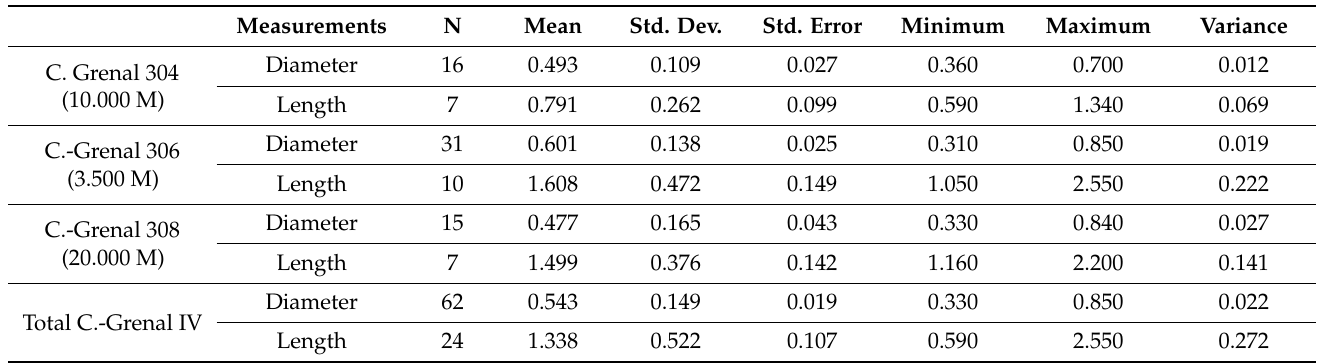
Table 1. Measurements in µ m (diameter and length) of the Combe-Grenal IV tartar bacteria , taken from the SEM pictures